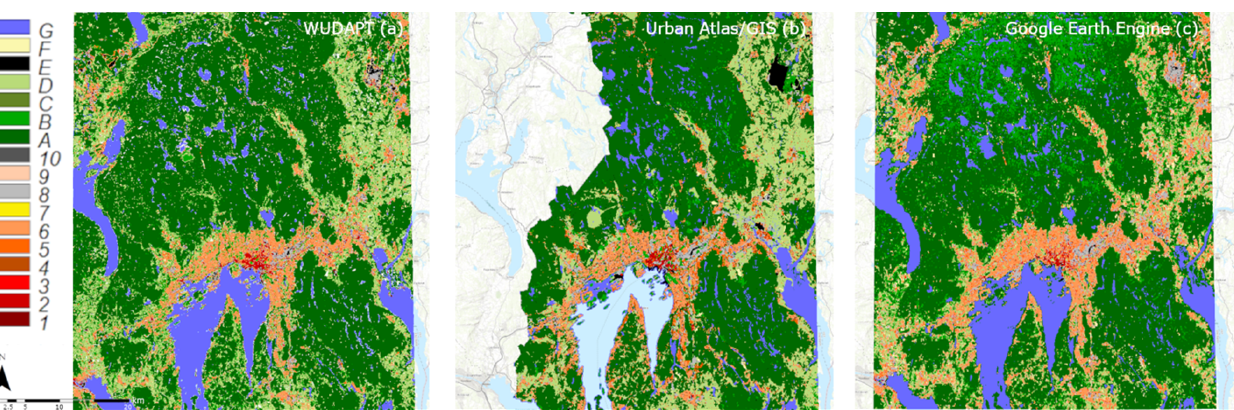
Figure 13. Distribution of LCZ by methodology, % with LCZ types as the color legend.